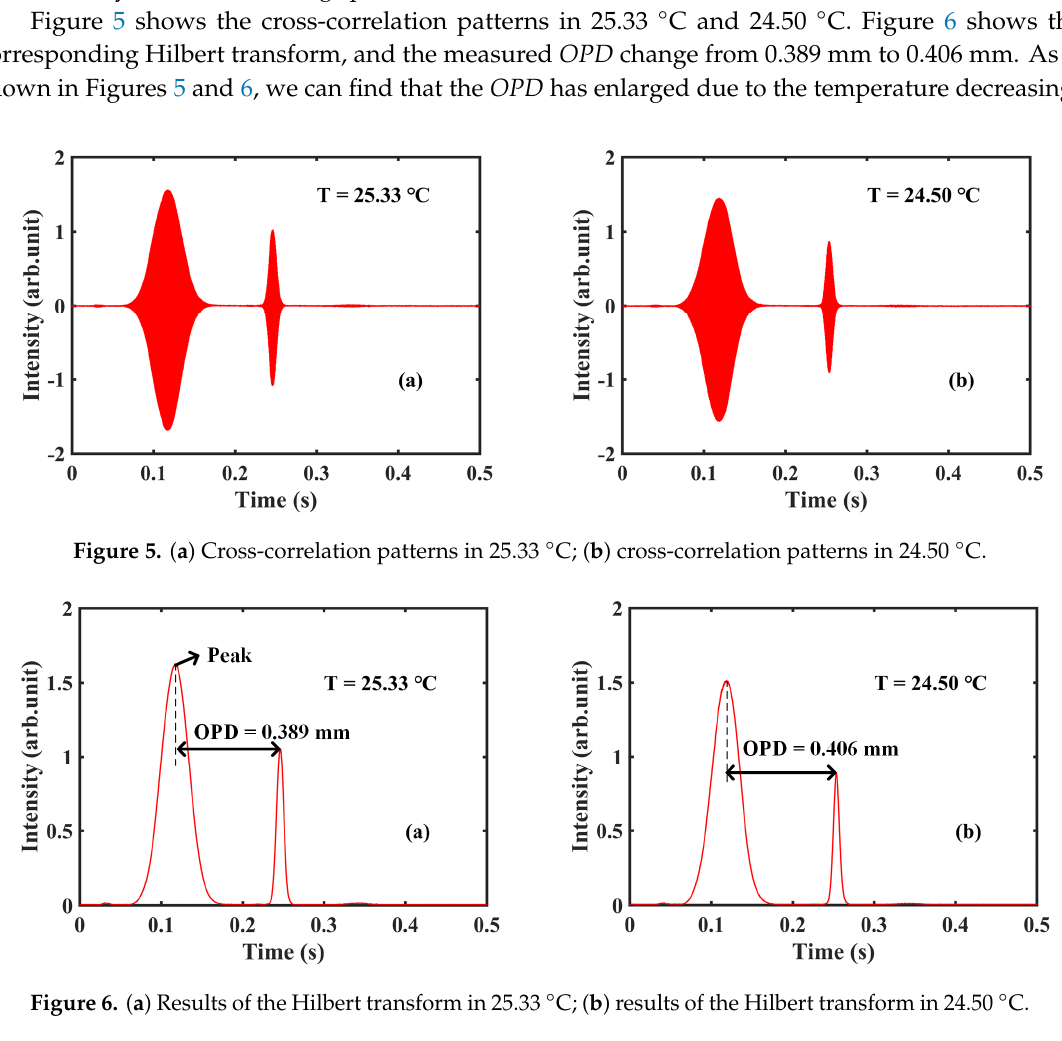
Figure 7. Long-term measurement of water temperature from 10:00 p.m. to 8:00 a.m. ( a ) Results obtained using temperature sensor and our method. Red solid circle: our method results, black solid